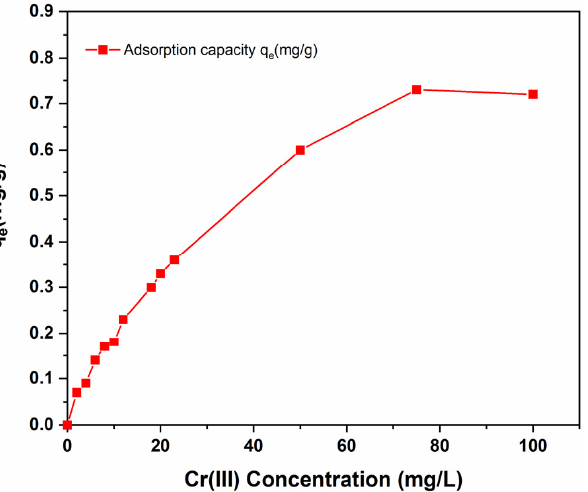
Figure 8. The of Cr (III) adsorption profile related to different concentration on 20 mg of C-